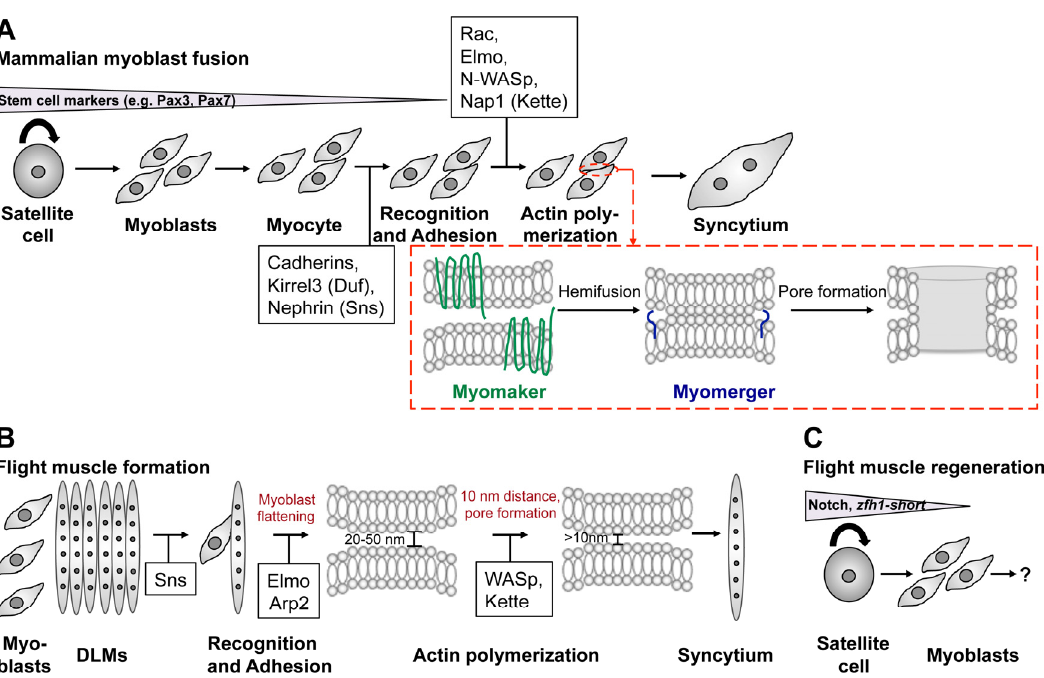
Figure 8. Common and different mechanisms in mammalian and Drosophila myoblast fusion. ( A – C ) Schematic representation of various steps in mammalian myoblast fusion ( A ) and Drosophila flight muscle development ( B , C ). ( A ) Many studies have used primary myoblasts or the murine C2C12 cell line to elucidate the role of Myomaker and Myomixer during myoblast fusion. Primary myoblasts derive by from satellite cells of skeletal muscles and are characterized by the expression of Pax7. Differentiation into myocytes and myotubes is achieved by the incubation in differentiation medium. Myoblast fusion involves recognition, adhesion, and actin cytoskeleton remodeling. Conserved players in this process are highlighted in the black boxes. Based on current knowledge Myomaker is responsible for inducing hemifusion ( red box ). Fusion pore formation involves the activity of Myomerger ( red box ). ( B ) During flight muscle development myoblasts migrate from the wing disc toward the DLM muscles and start to express Sns in the vicinity of the DLMs. The distance between the apposing membranes measures 20–50 nm. The Sns-expressing cell flattens, which requires the activity of Elmo and the Arp2/3 complex. WAVE- and WASp-dependent Arp2/3 activation brings the myoblast membranes in close proximity (<10 nm) and fusion pores are formed. ( C ) The identification of Zfh1-positive satellite stem cells opens new possibilities to study muscle regeneration in Drosophila